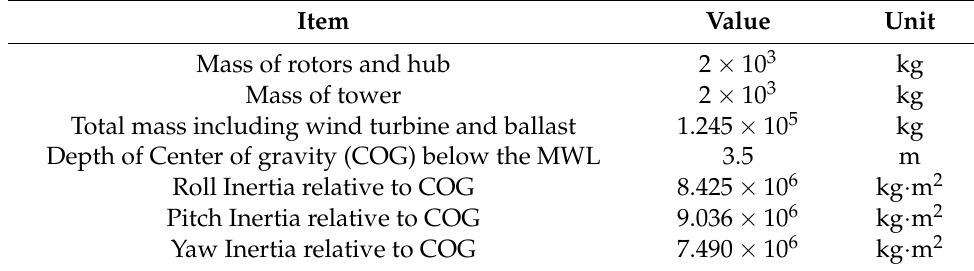
Table 2. Particulars of the floating